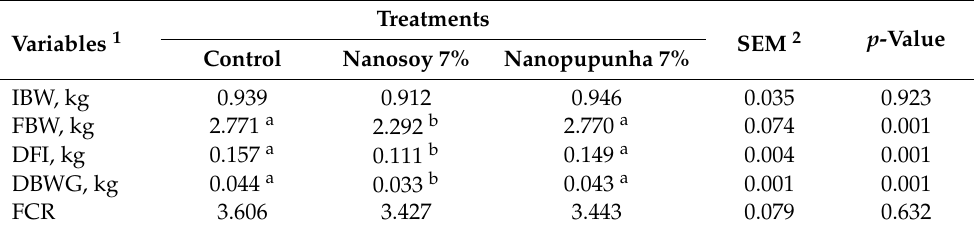
Table 2. Zootechnical performances of growing rabbits fed different sources of nanofibers and those fed a control